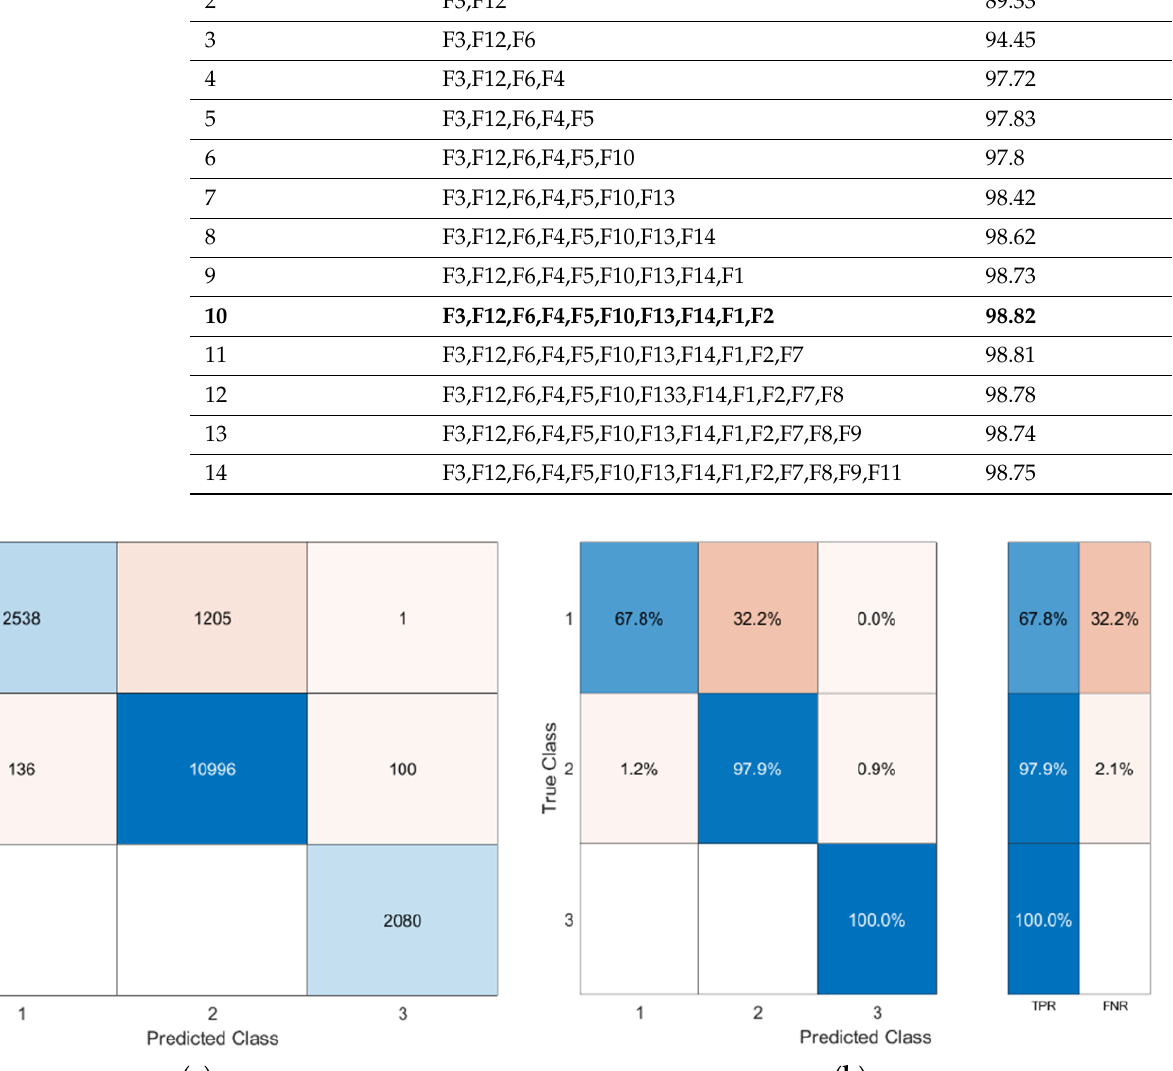
( b ) Figure 6. Confusion matrix corresponding to the highest accuracy shown in Table 6: ( a ) confusion matrix showing numerical values ( b ) TPR and FNR (in percentages). N u m b e r s o f i n t e r n a l D C f a u lt s e v e n t s t r u e l y d e t ec t e d a s C l a ss - 1 D e p e nd i b i li t y = (8) Table 7. Performance of fault detection using SFS with SVM (five-fold cross-validation). No. of Features